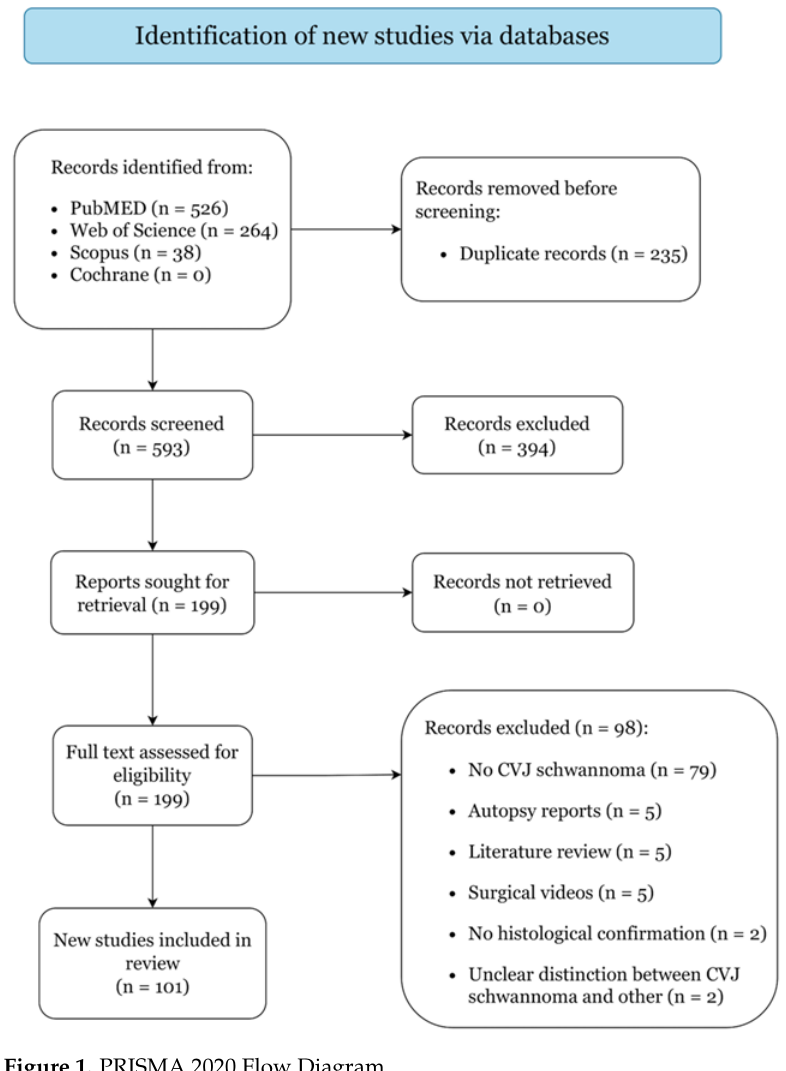
Figure 1. PRISMA 2020 Flow Diagram. Table 1. Summary of demographics and clinical